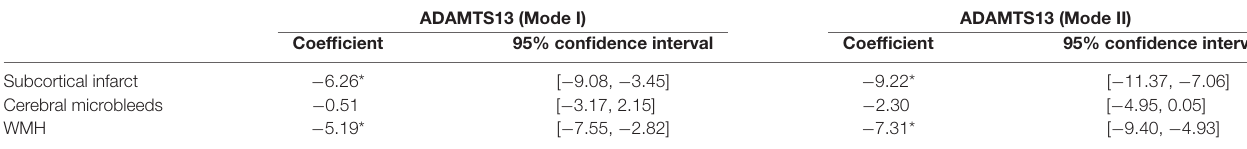
TABLE 2 | Multivariate analysis of ADAMTS13 levels with brain variable.